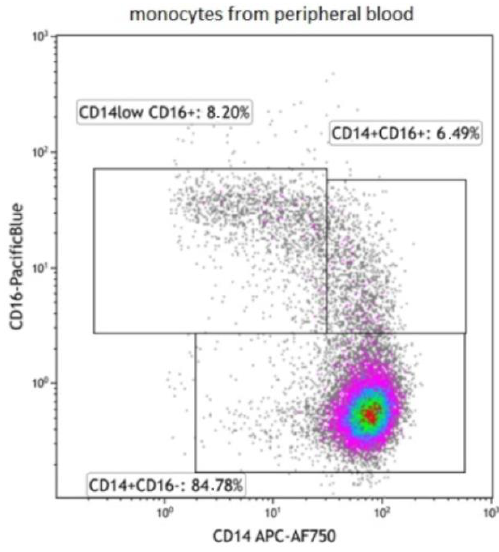
Figure 1. Gating strategy of monocyte subpopulations.